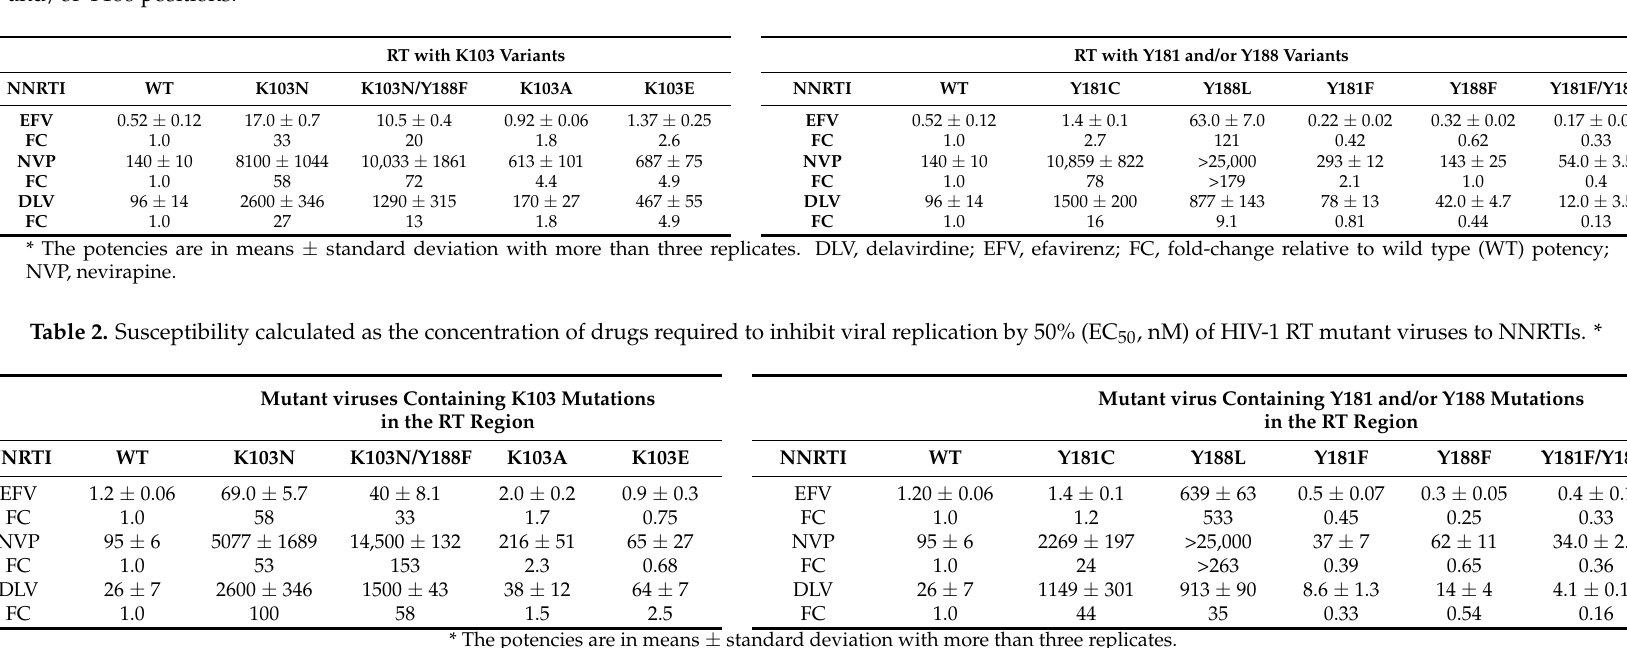
Table 1. Inhibitory potency of non-nucleoside reverse transcriptase inhibitors (NNRTIs) (IC 50 , nM) against RT containing different substitutions at the K103, Y181, and/or Y188 positions. * RT with K103 Variants RT with Y181 and/or Y188 Variants